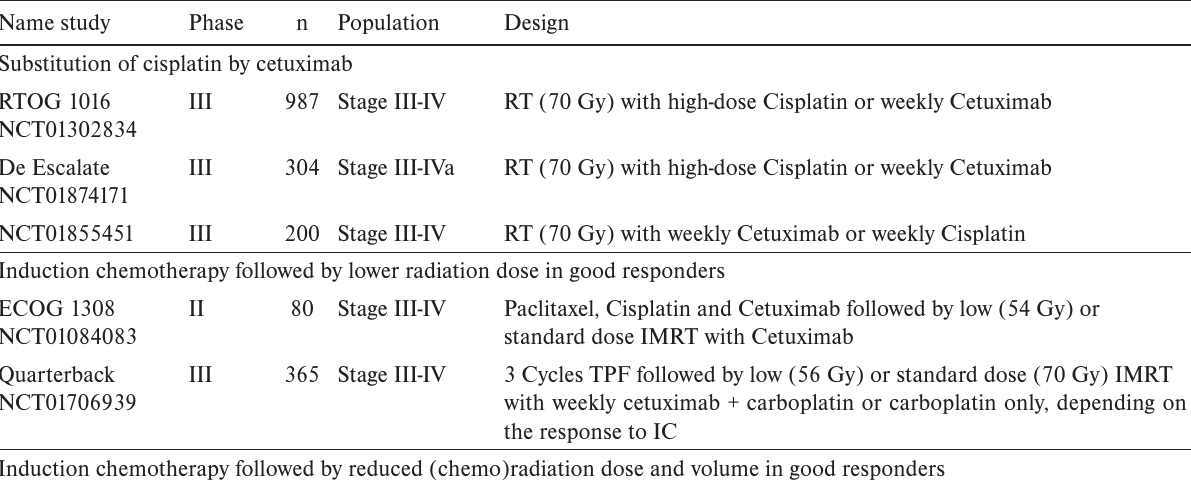
Table 3. Selection of treatment de-escalation trials for HPV-driven oropharyngeal